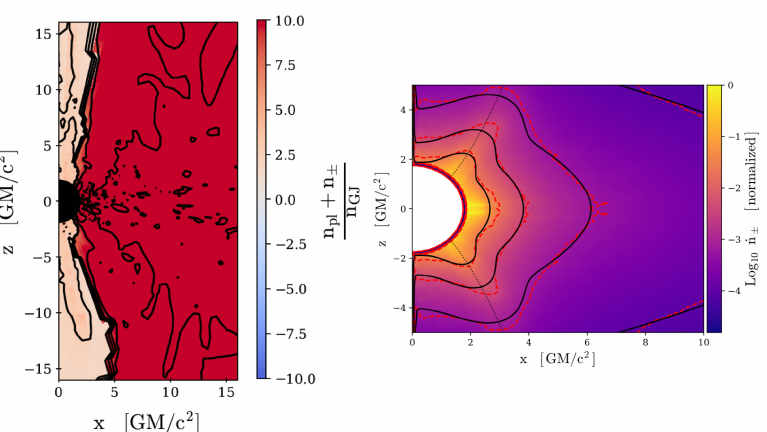
Figure 1. ( Left panel ) The ratio of the available pair density to the Goldreich-Julian density for a GRMHD simulation model with a = 0.5. ( Right panel ) The time-averaged logarithmic rate of the pair production density taken from [40] as a function of the position. In each panel, the horizontal axis presents the radial coordinate while the vertical axis shows the height above the disk mid-plane. From the plot, it is inferred that the pair production rate is enhanced in the inner part of the accretion disk and in the equatorial plane. Dashed red lines and solid black lines compare the numeric and the fits to the contours of the rate of the number density. See [40] for more